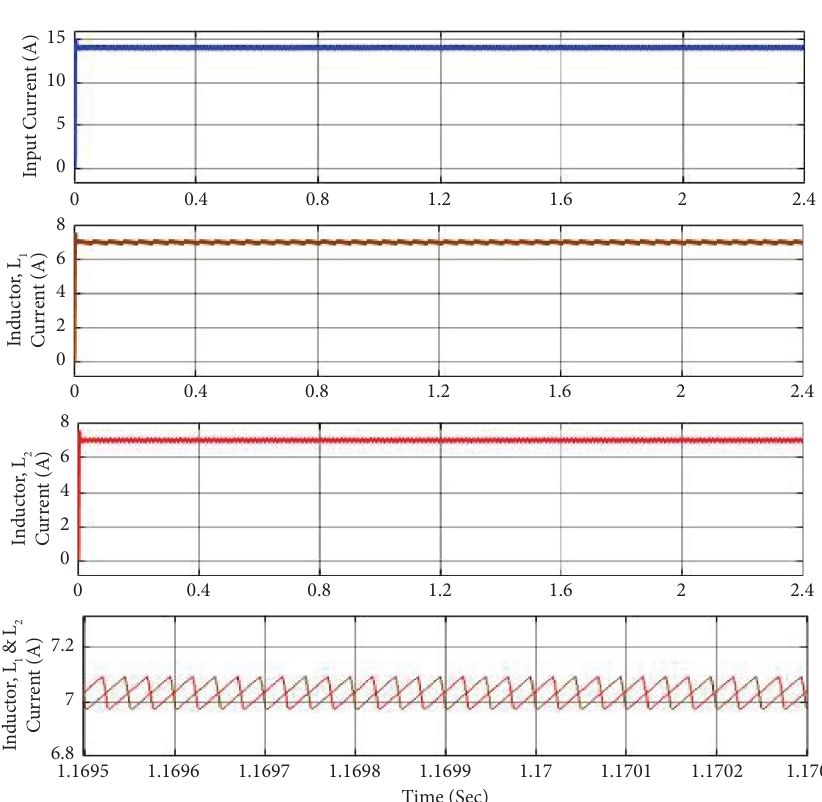
Figure 12: Current profle at input, inductor L